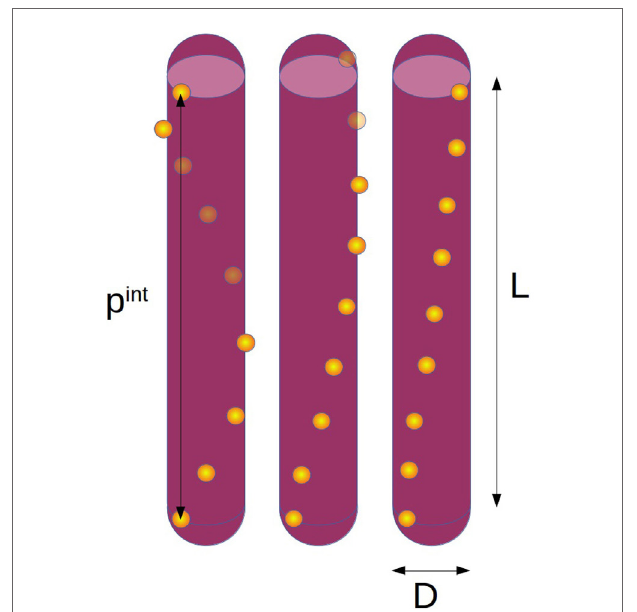
FigUre 1 | sketch of the simulation model with length L , diameter D , and different internal pitches (left p int = L , middle p int = 2 L , right p int = 4 L ) with the number of point charges per rod n pc = 9